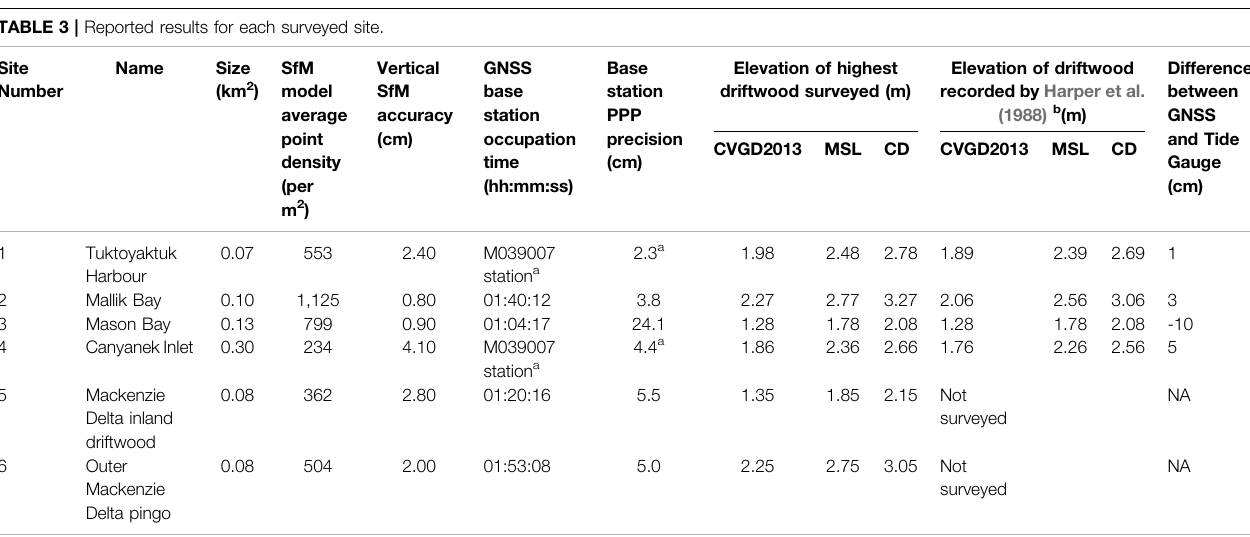
TABLE 3 | Reported results for each surveyed